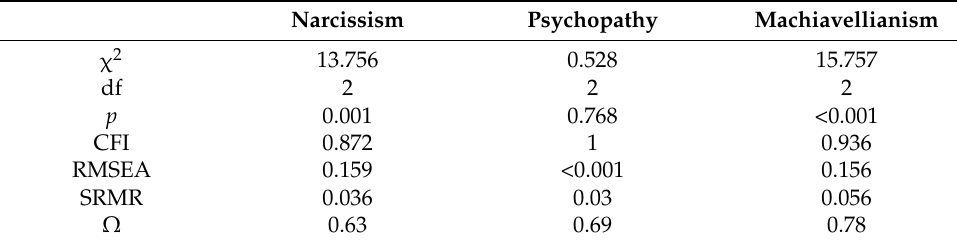
Table 7. Model fits for all measurement